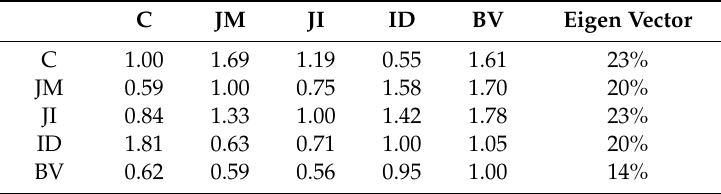
Table 7. Average pairwise comparisons and the Eigen vector for RCP culvert